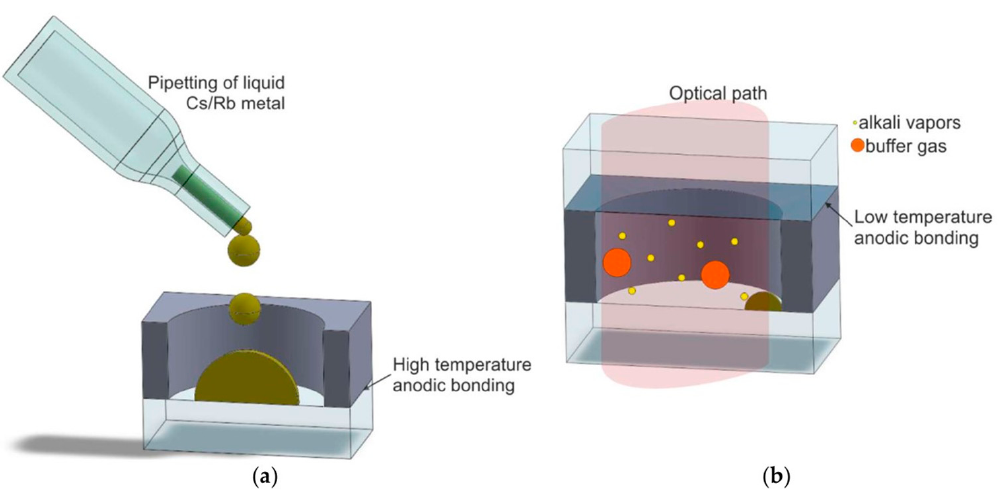
Figure 12. Atomic vapor cell preparation by direct filling of alkali metal monomers. ( a ) pipetting of liquid alkali metal, ( b ) optical path of alkali vapor cell. Reprinted from Ref [56].